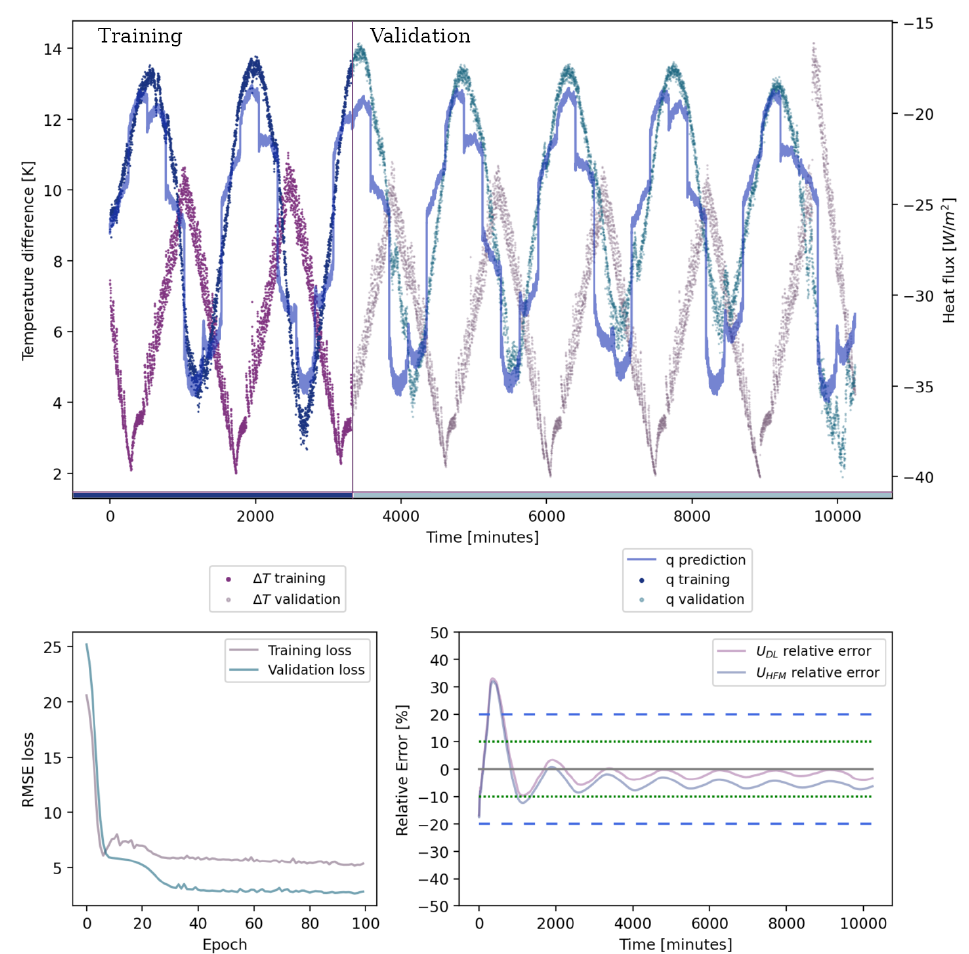
Figure 7. Results for the deep-learning model developed for S1 under winter conditions. The other two specimens, S2 and S3, are insulated walls with the same U -value ( U ISO = 0.21 W/(m 2 K)) but different cross sections. The base for both is a 13.5 cm thick concrete wall. The insulation of S2 consists of 16 cm mineral wool facing the climatic chamber, while 16 cm EPS facing the laboratory was used for S3. Both specimens performed best in winter conditions in terms of the quality of the results. The selected LSTM deep- learning model is a model with 16 LSTM layers for S2 and a model with 8 LSTM units for S3. The time series were rearanged in batches of 128 points for S2 and 256 points for S3. Overfitting was again solved by dropout ( p = 0.5 for both cases) and L2 regularization ( λ = 0.01 for S2 and λ = 0.02 for S3). The model for S2, trained over 100 epochs (see Figure 8), again outperforms the HFM measurement result when considering the U -value. The final U -value not only has a lower relative error compared to U ISO , but also shows a more stable U -value solution over the entire measurement period. Although the model for S3 was trained over 300 epochs, it shows a worse solution than the model for S2, which has a stable solution with a relative error of about 10%, compared to U ISO . The reason for these more stable solutions is discussed in Section